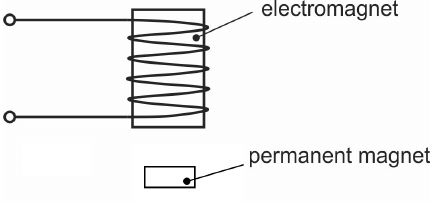
Figure 2. Scheme of a magnetic levitation system.